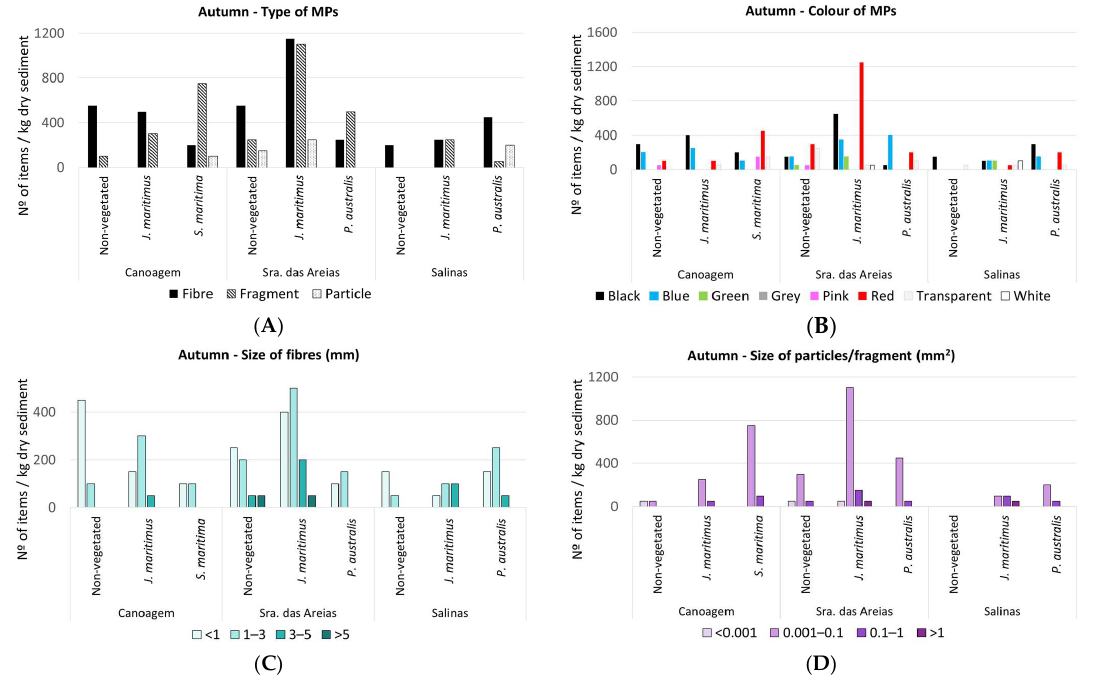
Figure 2. MPs content (number of items per kg of analysed dry sediment) and characterization from sediments collected in autumn (November 2021), discriminated by: ( A ) type of MPs; ( B ) colour of MPs; ( C ) size of fibres (mm); ( D ) size of particles and fragments (mm 2 ). In general, for this sampling campaign, in terms of sites sampled, Sra. das Areias had the highest MPs concentrations and there was a general tendency for higher MPs content in vegetated sediments than non-vegetated ones (Figure 3). The type of MPs more frequent in non-vegetated sediments was fibre, whereas, for vegetated samples, particle/fragment abundance was, in general, similar to fibre (Figure 2).